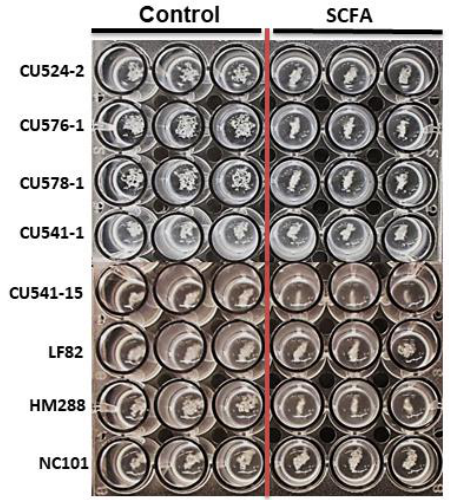
Figure 6. c-SCFA inhibit yeast agglutination by E. coli . E. Coli were grown in LB media (pH = 6.5) with either 123 mM NaCl (control) or SCFA at 37 °C for 18 h. After centrifugation, the cell pellets were resuspended in PBS, followed by mix with equal volume of yeast suspension at the same optical density (OD 600 = 5.2) (see Methods). Table 5. Yeast agglutination scores*.